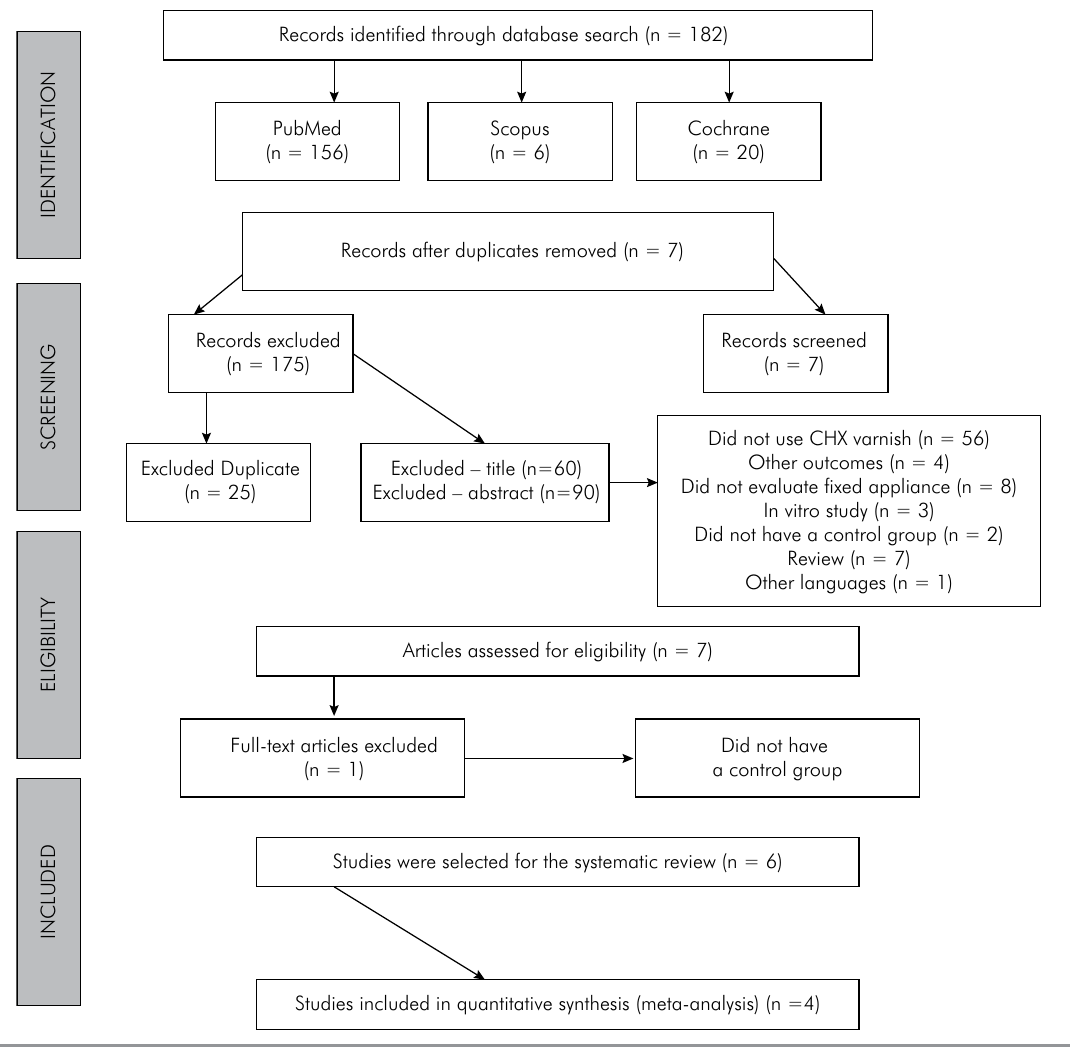
Figure 1. Literature search flow